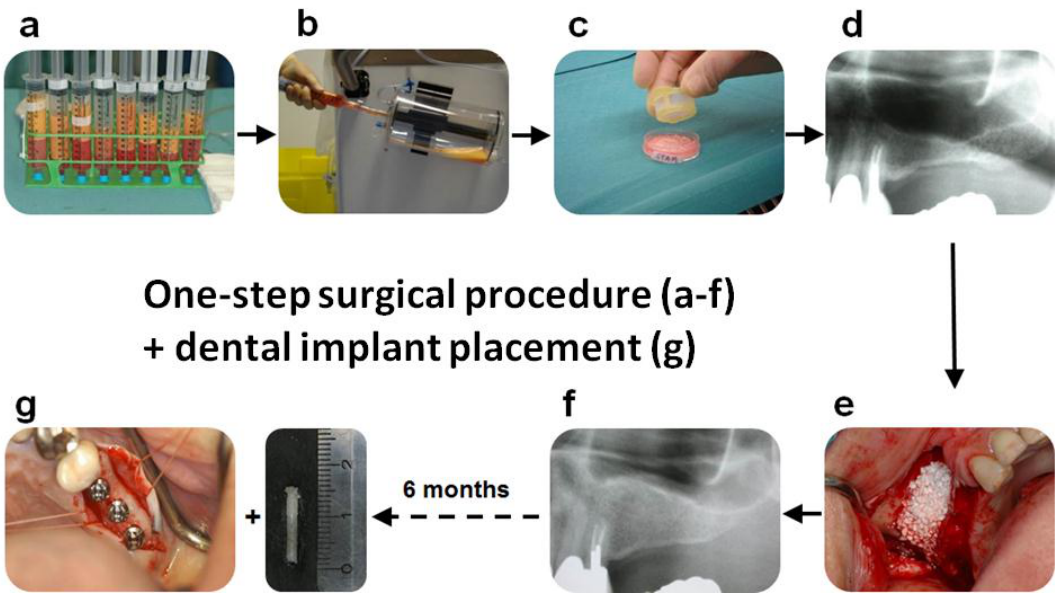
Figure 1. Concept of a sinus floor elevation with freshly isolated adipose-derived stem cells in a one-step surgical procedure. ( a ) The adipose tissue and liposuction fluid obtained by liposuction is collected in syringes; ( b ) the filled syringes are transferred into a Celution 800/CRS system to obtain the fresh stromal vascular fraction containing the adipose stem cells; and ( c ) the freshly isolated adipose stem cells are seeded onto the calcium phosphate scaffold. Unattached cells are washed off. During the short attachment period of the cells (30 min), the patient is prepared for the maxillary sinus floor elevation procedure via a lateral approach; ( d ) the anatomical selection criterion was a pre-existing (native) alveolar bone height of >4 mm obtained from the preoperative panoramic radiograph; and ( e ) after reflection of the mucoperiosteal flap, a bony window is created in the lateral wall of the maxillary sinus and carefully moved and rotated medially toward the maxillary sinus, after dissection of the maxillary sinus mucosa (trap-door technique). The calcium phosphate scaffold is inserted immediately into the patient, and the space created is filled with the bone substitute combined with the adipose stem cells. Finally, the wound is closed; ( f ) after a healing period of five months post-MSFE (prior to dental implant placement), a panoramic radiograph is made to determine the increase in vertical height bone + bone substitute at the planned dental implant positions; and ( g ) after six months, bone biopsies are taken by using a hollow burr for histomorphometrical and immunohistochemical analysis, and dental implants are placed.